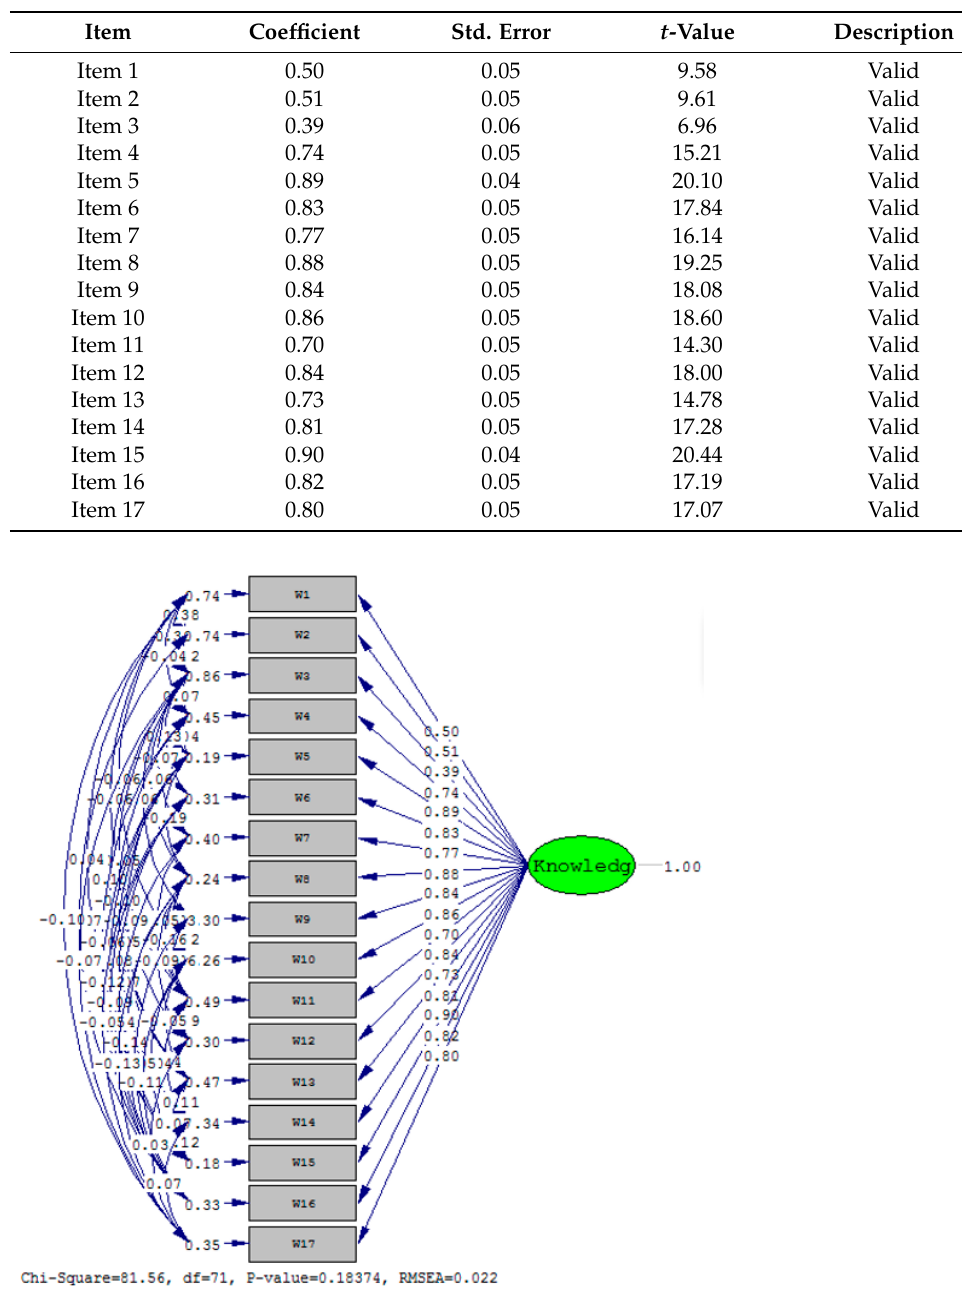
Figure 1. Diagram of CFA of the Islamic Religious Moderation Knowledge Scale.